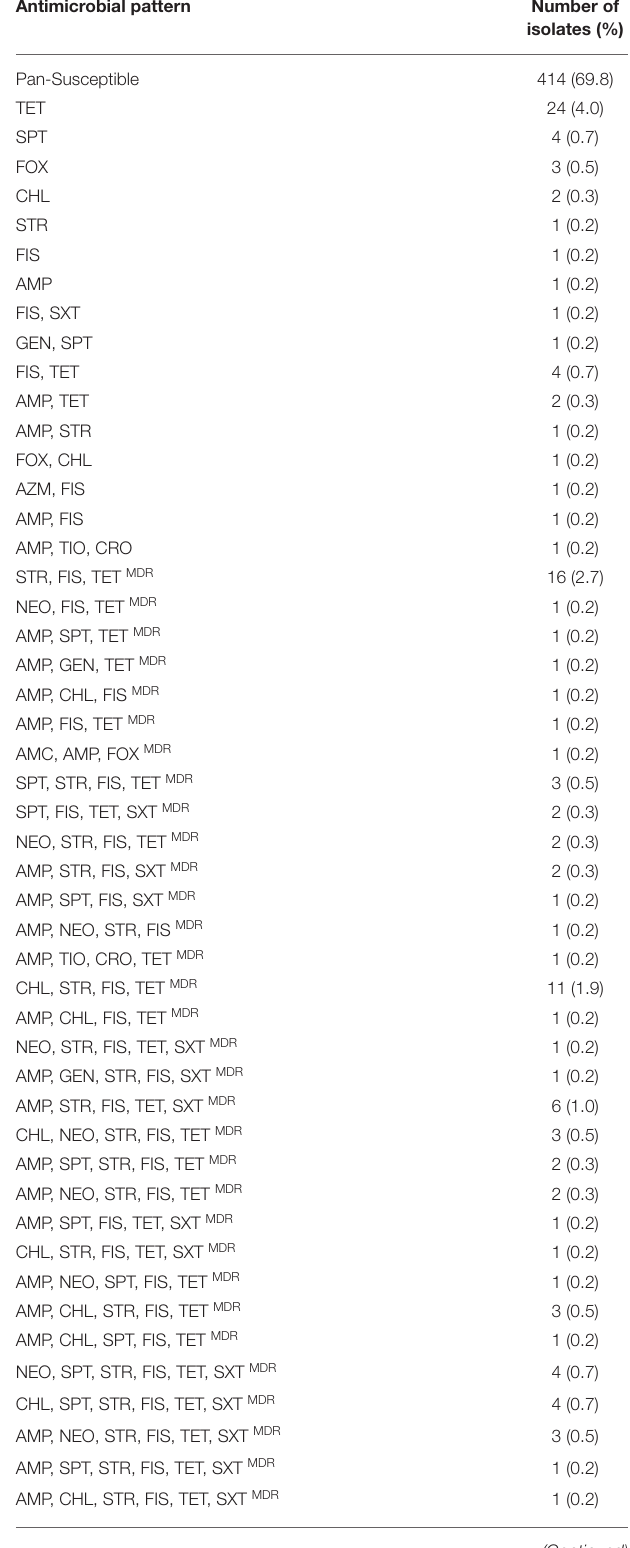
TABLE 2 | Antimicrobial resistance patterns of 593 Escherichia coli isolated from calf or cow feces or manure pit of 101 dairy farms in Québec Canada. Antimicrobial